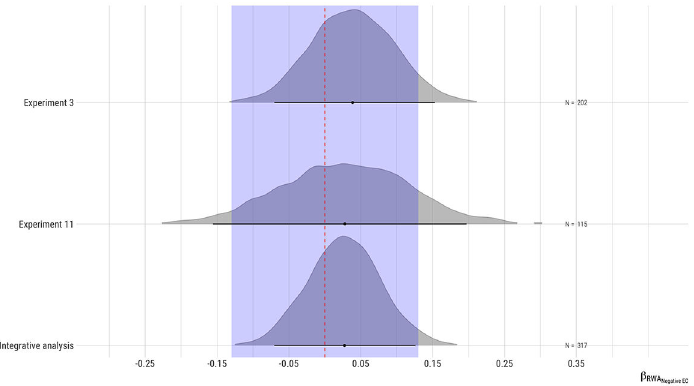
Note. The purple area corresponds to a region of practical equivalence where the values are considered equivalent to 0 (Kruschke, 2018). More information can be found in the Supplementary